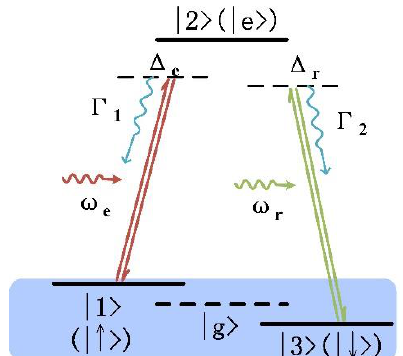
Figure 1. The schematic diagram of a Λ three-level system. The ground state is split into two fine energy bands, caused by the Rashba effect, in the ming blue background. |1> and |3> are spin-up or -down, respectively. |e> is a virtual state in the stimulated Raman scattering process, Γ 1 and Γ 2 are the decay